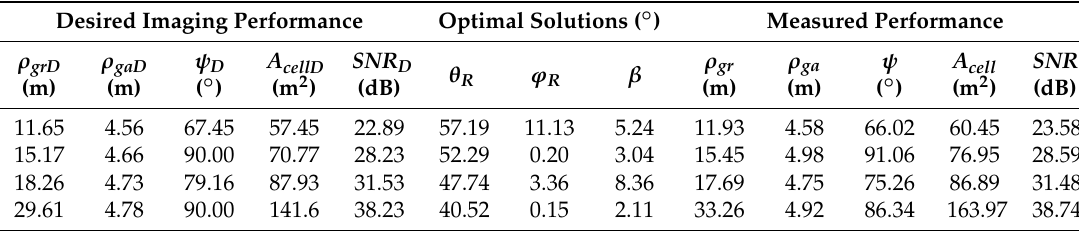
Table 3. Key parameters relevant to three bistatic formations. Desired Imaging Performance